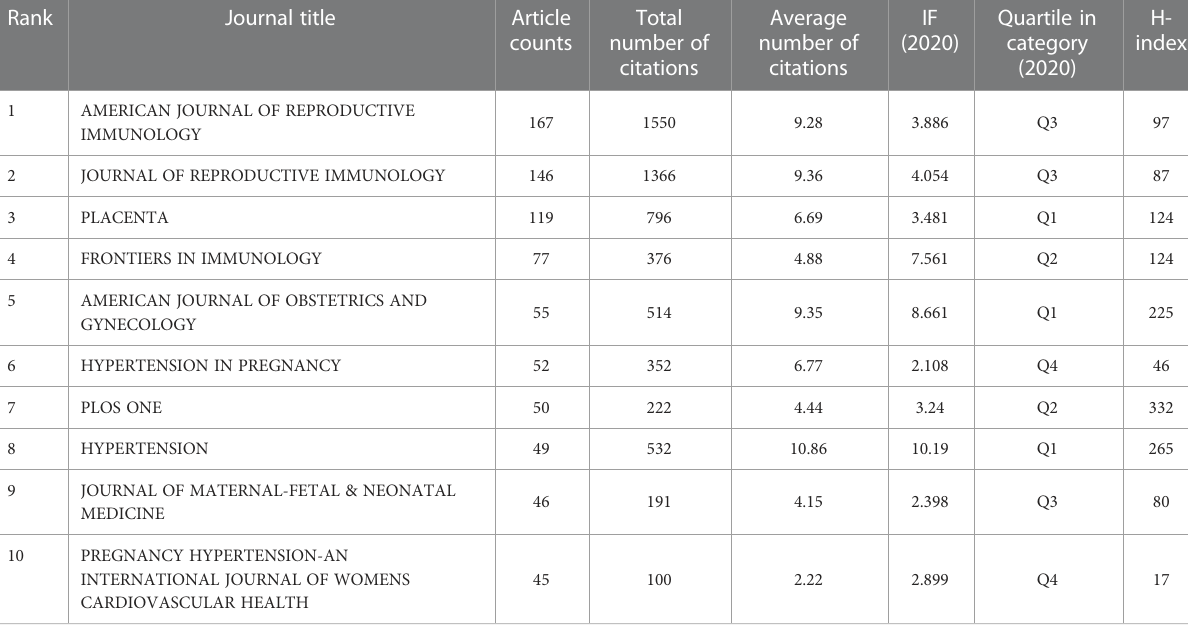
TABLE 3 The top 10 most productive journals published in HDP and immune cells research.